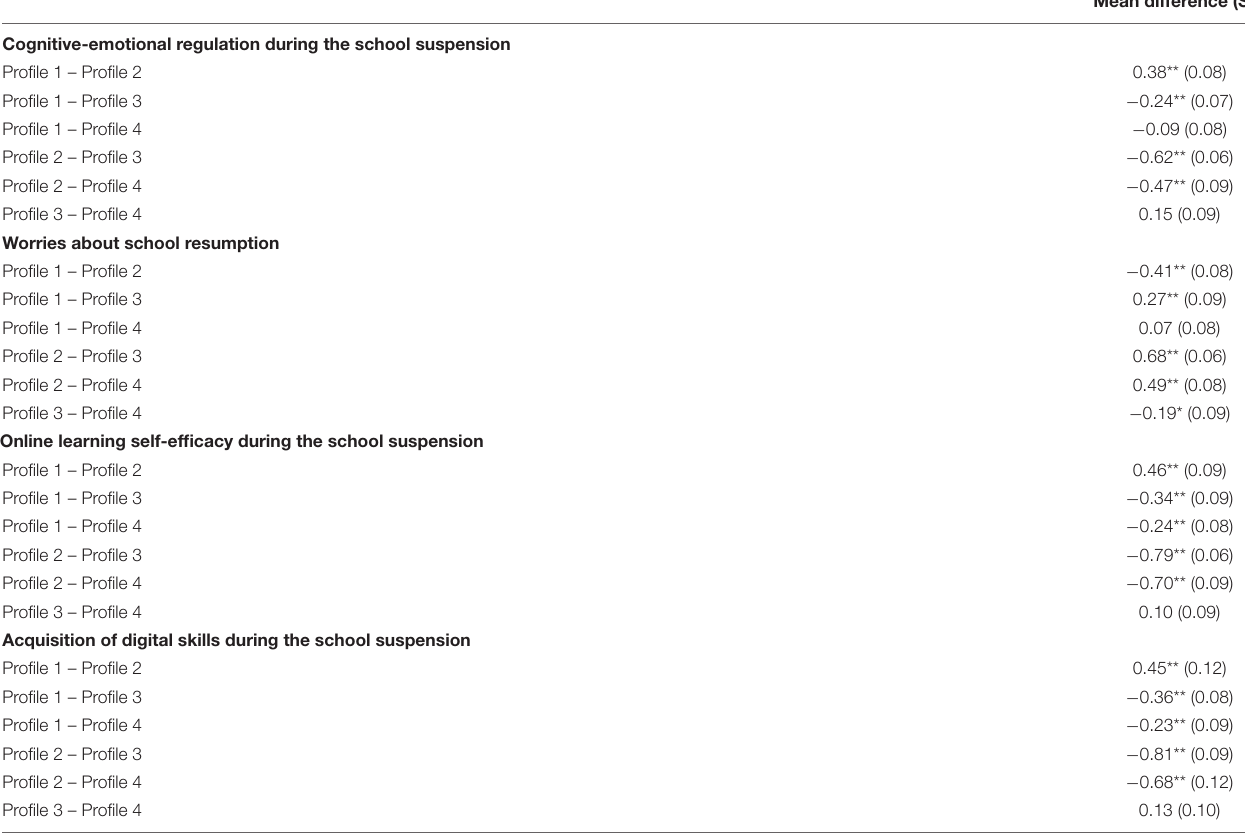
TABLE 14 | Comparison of student outcomes (secondary